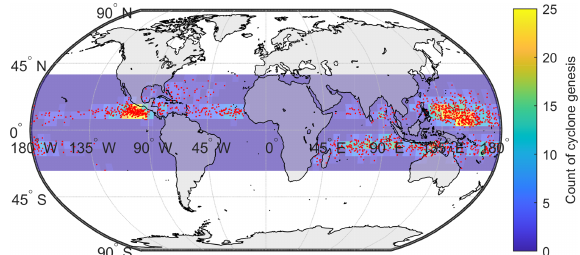
Figure 4. Spatial distribution of genesis points (tropical cyclones over 35ms − 1 in IBTrACS). The color scale corresponds to the count of cyclones per 5 × 5 ◦ box (truncated to 25 for scaling rea- sons). The genesis location corresponds to the first reported point of each